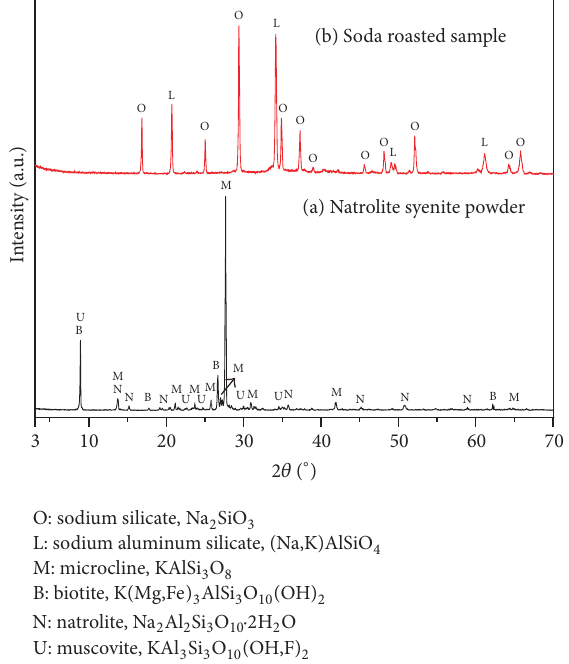
Figure 1: XRD patterns of natrolite syenite powder (a) and soda roasted sample